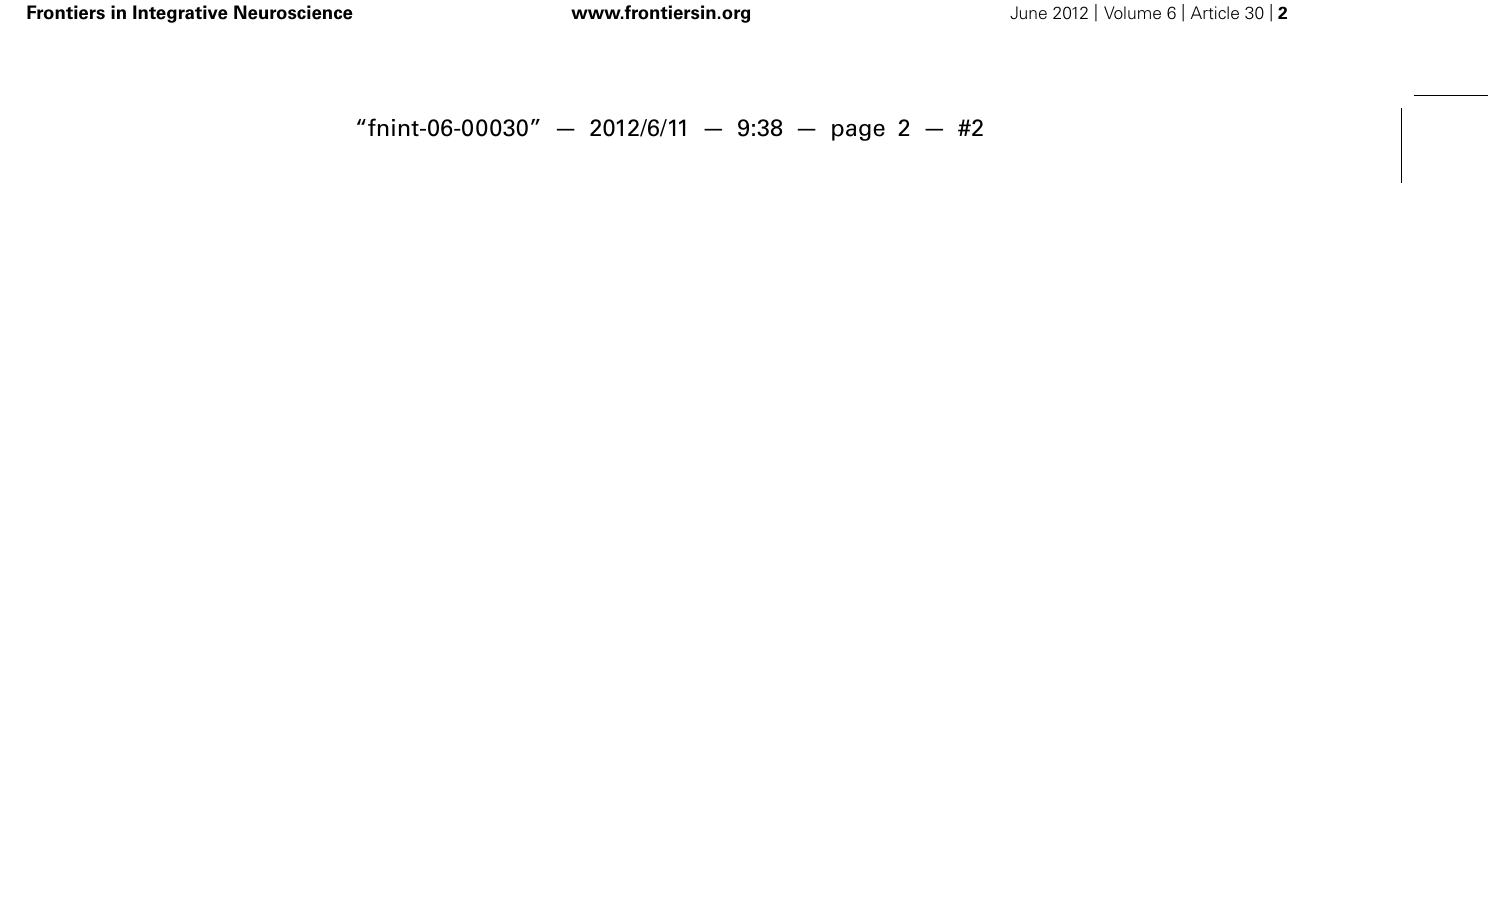
over layer 4, of the illustrated frame in (B) . Scale bar, 1 mm. (B) Individual frames (300 ms) from representative movies of a thalamically evoked network activation (triggered, gray, left) and a spontaneous network activation (spontaneous, green, middle) in the same slice. Each movie progresses from top to bottom as indicated by the arrow. Core frames indicate cells active in the same order across all movies ( n = 11) from this slice, indicated in red. Scale bar 50 μ m (adapted from MacLean etal.,